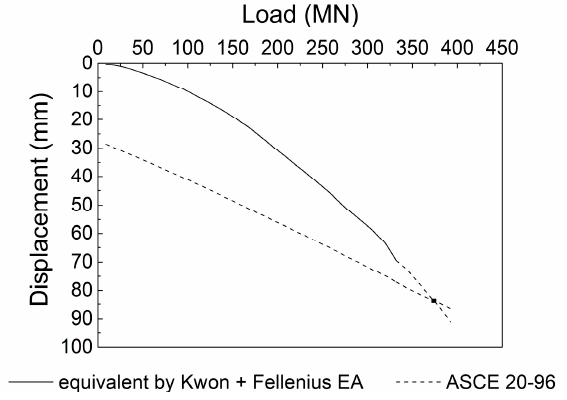
Figure 9. Determination of the ultimate total resistance value at TP 1.